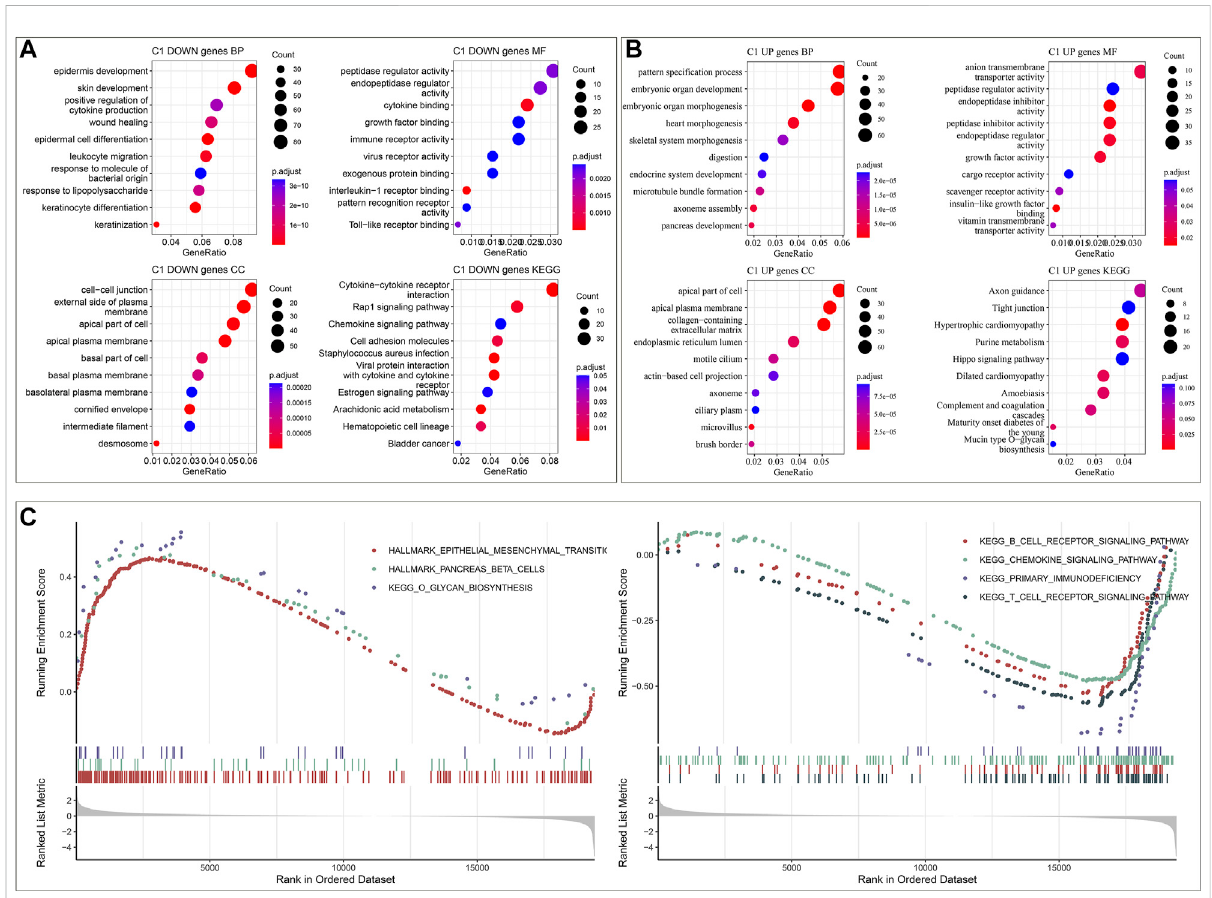
FIGURE 2 Immunesubtypes-relevantgenesandtheirbiologicalsigni fi canceintheTCGAdataset. (A) Themainbiologicalprocess(BP),molecularfunction (MF), cellular component (CC) and KEGG enrichment results of genes with down-regulation in IC1. (B) The main BP, MF, CC and KEGG enrichment results of genes with up-regulation in IC1. (C) GSEA for the main Hallmark and KEGG pathways activated in IC1 or